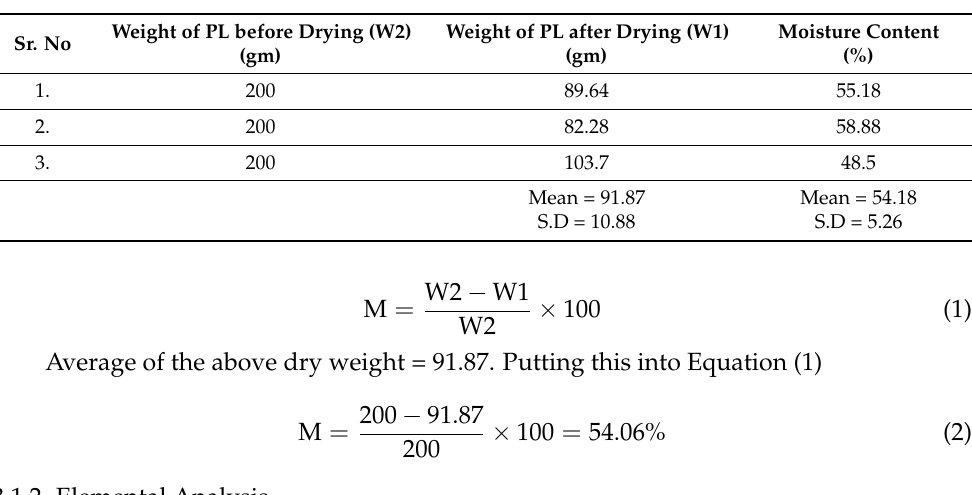
Table 1. Moisture content of poultry litter.